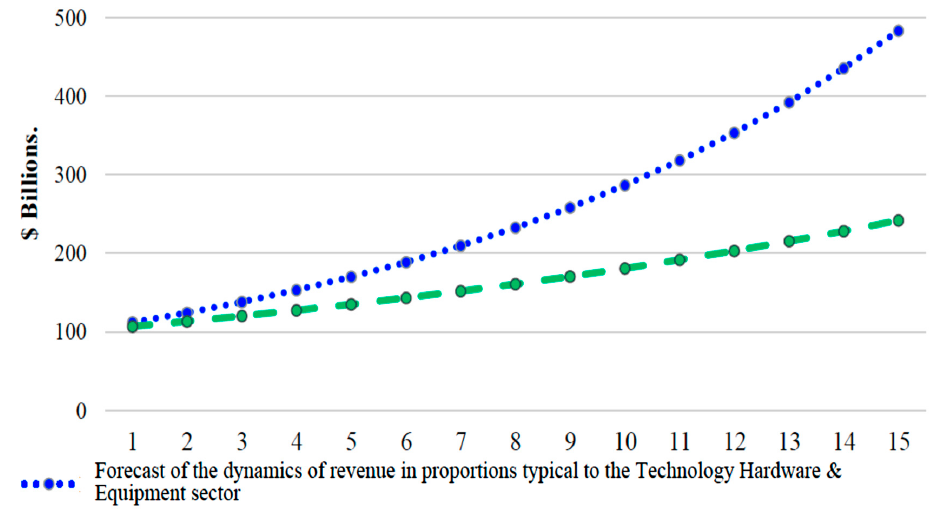
Figure 7. Forecast of the dynamics of revenue of Oil and Gas sector in proportions typical for the growth of the Automobiles & Components and Technology Hardware & Equipment sectors 2018–2032, billion dollars. Source: calc. by author by data [56].